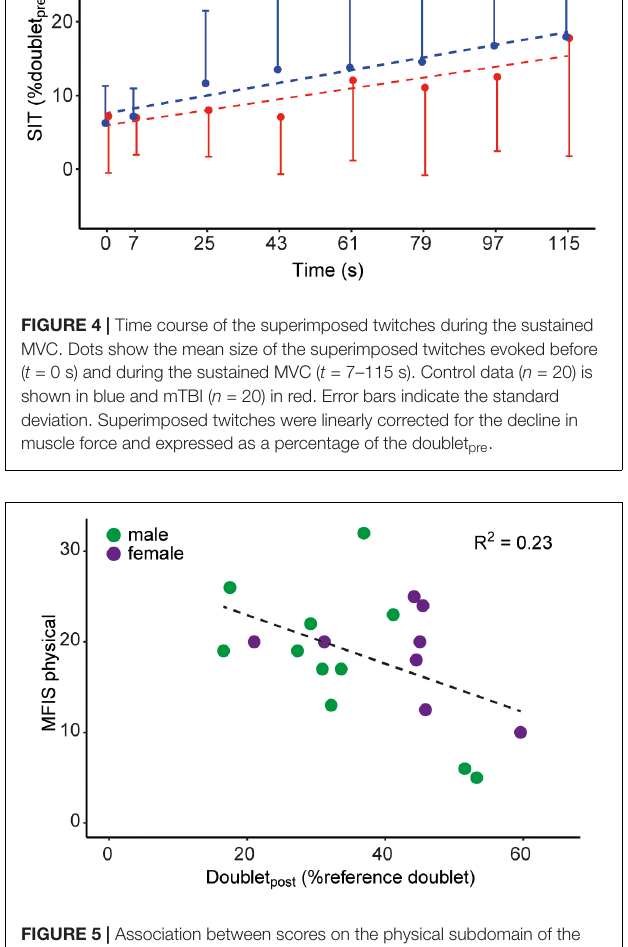
FIGURE 5 | Association between scores on the physical subdomain of the MFIS and the decline in the evoked doublet-force after the sustained MVC (i.e., doublet post ). Male mTBI participants ( n = 11) are shown in green, female mTBI participants ( n = 8) are shown in purple.